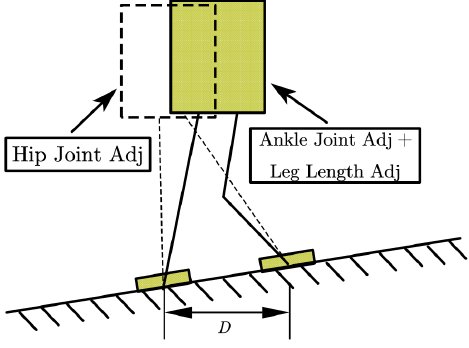
Figure 4. Illustration of the leg length compensation